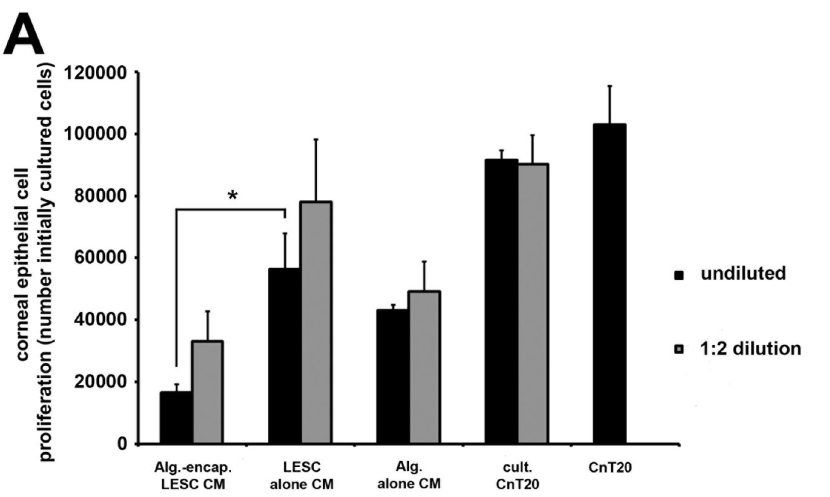
Figure 3. LESC conditioned medium modulates corneal epithelial cell proliferation. Data points represent the mean (n=3 6 S.E.M.) number live cells extracted. * P # 0.05 indicate differences between culture conditions.